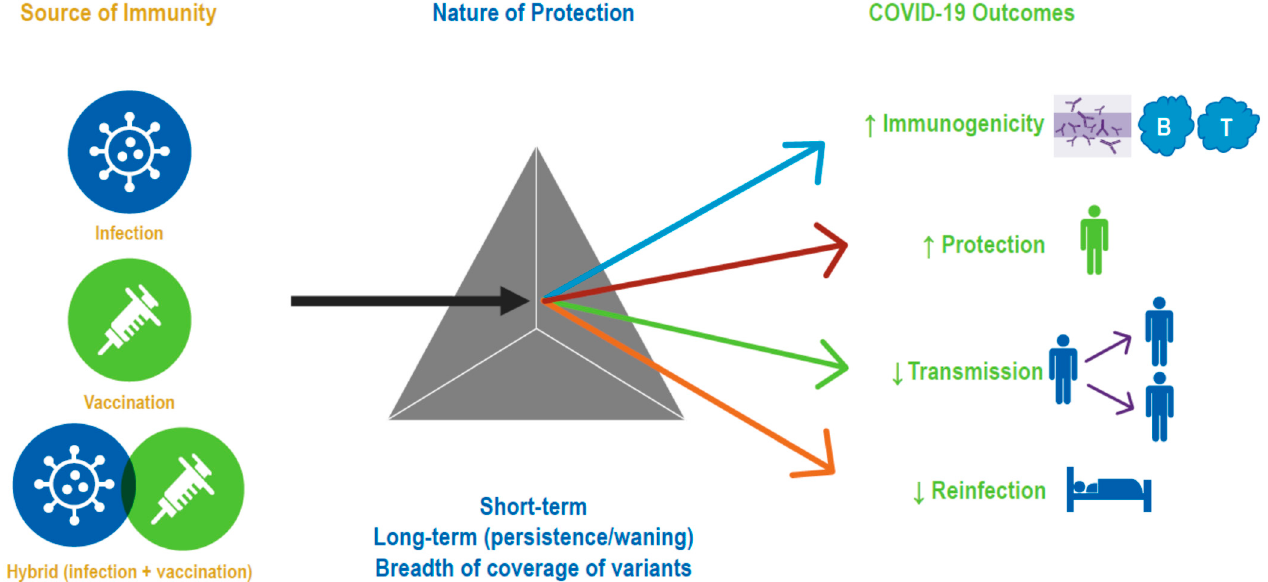
Figure 2. Evidence synthesis approach/strategy. The gray triangle symbolizes three types of immune protection, namely that obtained through vaccination, infection, or a combination of both. Accumulating data have enhanced our understanding of the Nature of Protection conferred by the three types of immunity against various COVID-19 outcomes.